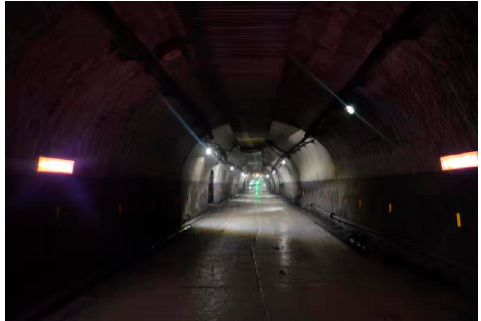
Figure 5. Underground tunnel for experiment.